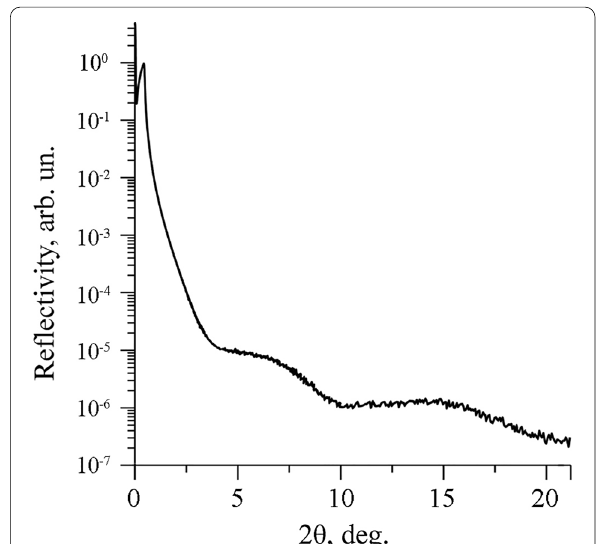
Fig. 5 Experimental X-ray reflectivity curve of the polished BDD plate